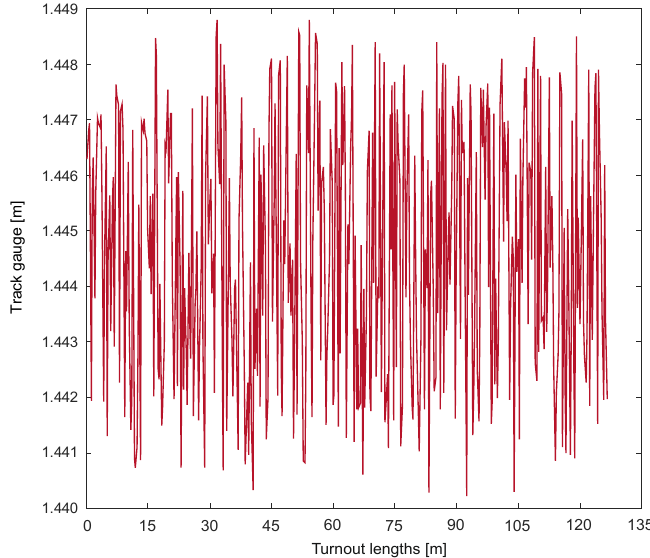
Figure 5. Track gauge in the rail turnout.